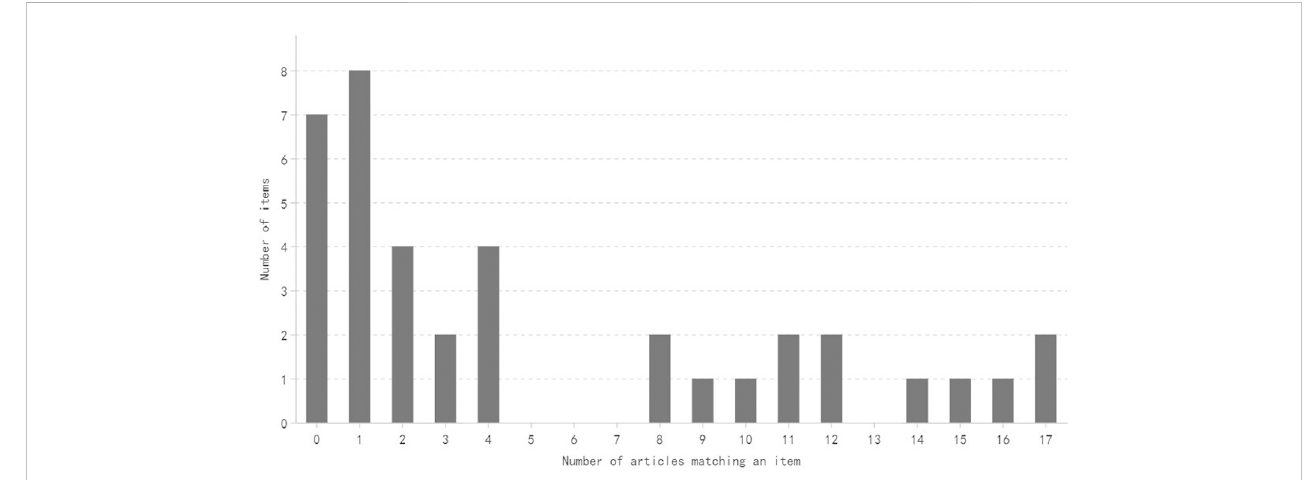
FIGURE 3 Distribution of the number of CONSORT-CHM items satis fi ed by a speci fi c mumber of